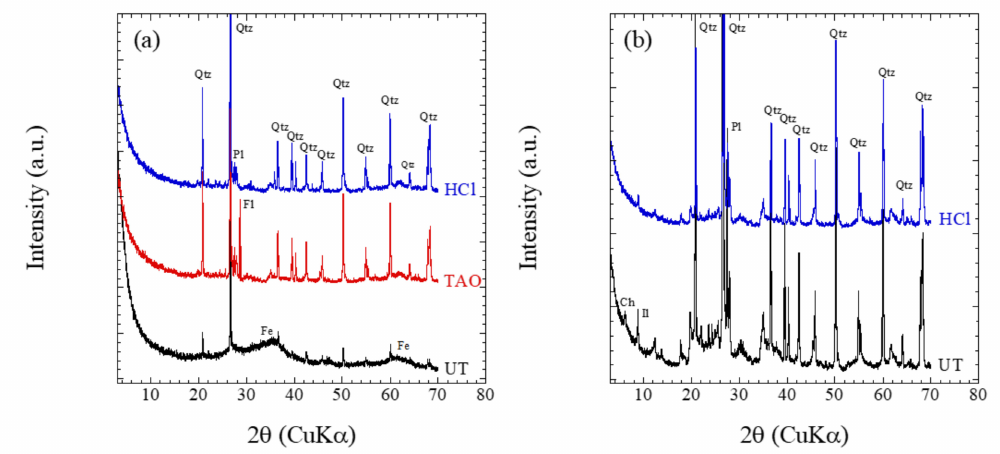
Figure 4. Typical XRD patterns of the aggregate before and after some sequential extractions. Abbreviations: UT: untreated samples; TAO: after Tamm’s acid oxalate (TAO)-treated samples; HCl: after 6 M HCl-treated samples; Ch: chlorite; Fe: ferrihydrite; Fl: fluorite; Il: illite; Pl: plagioclase; Qtz: quartz. ( a ) Rimstone basins. Ferrihydrite has the usual peaks at about 0.26 nm and about 0.15 nm, which are broad due to weak crystallinity. The peak of fluorite appears due to disappearance of ferrihydrite by TAO treatment, but disappears with 6 M HCl treatment. Fluorite occurs as a major gangue mineral of the Takatori tungsten mine, where the Takatori mine is located approximately 6 km east of the Ayuta Mine (Figure 1) [10,11]. Thus, this area may have been mineralized by veins including fluorite in the Takatori mine. The peak strength of quartz increases with the treatments because ferrihydrite and other materials are removed in each treatment. ( b ) Materials below basins of rimstone. Materials consist of chlorite, illite, plagioclase, and quartz as crystalline